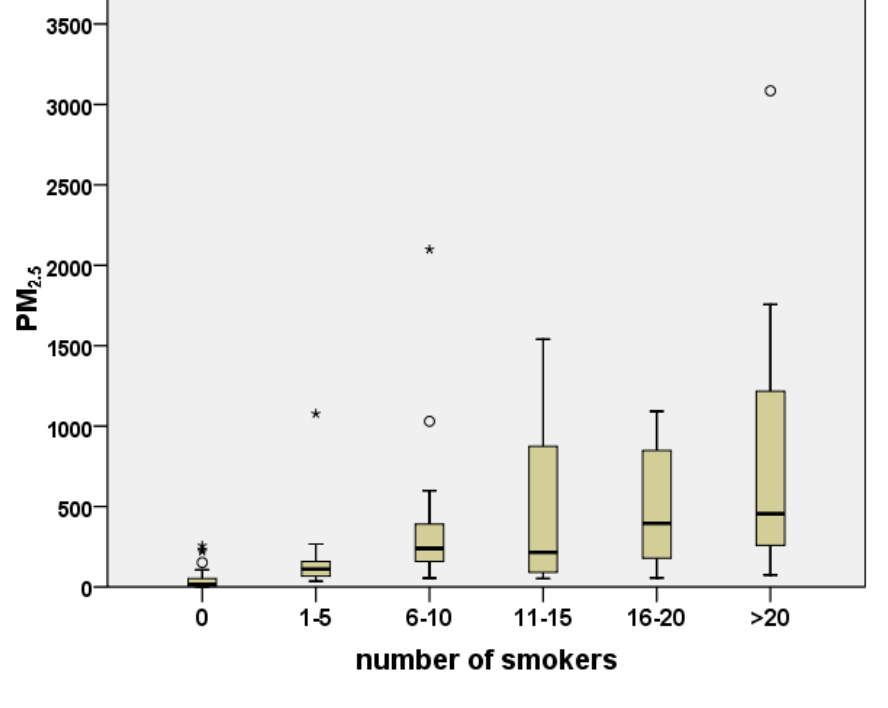
concentrations grouped by number of smokers 2.5